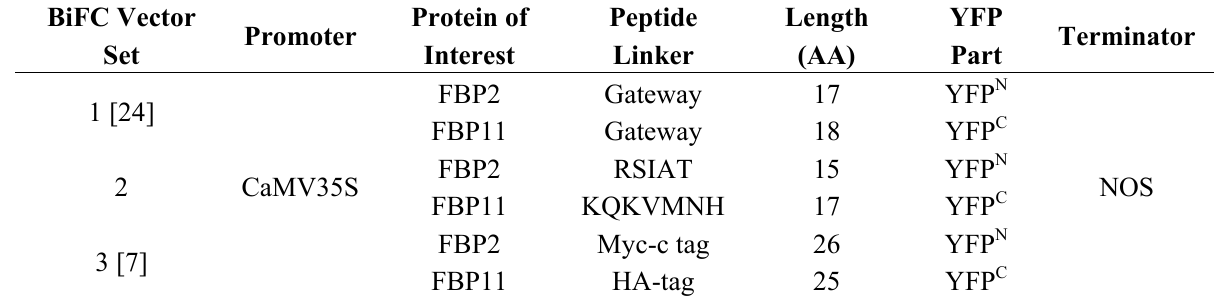
Table 1. Overview of BiFC constructs with different peptide linker sequences between the coding regions of the YFP halves and the coding regions of two interacting petunia MADS (MCM1, AGAMOUS, DEFICIENS and Serum Response Factor) domain transcription factor proteins. The indicated linker lengths include amino acids (AA) encoded by parts of the multiple cloning site. Vector combinations were tested upon transient transfection of petunia protoplasts. All expression cassettes were embedded in a pUC vector backbone. Peptide linker sequences: Gateway-based cloning linker sequence